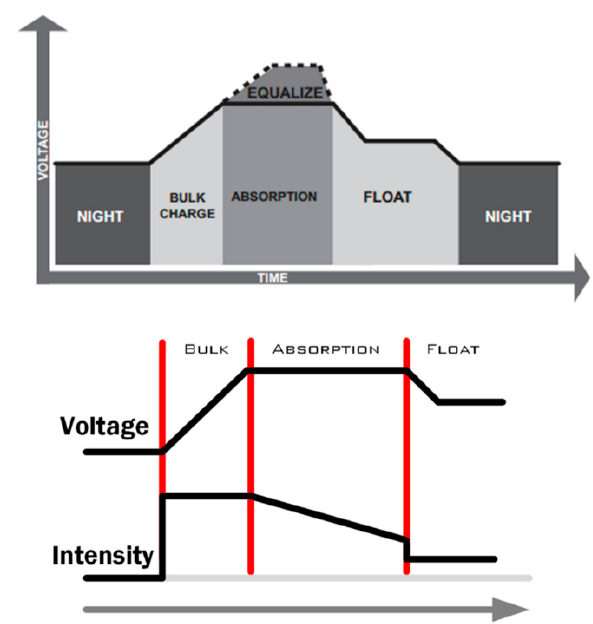
Figure 2. Four-stage battery-charging algorithm (Tristar MPPT Manual).